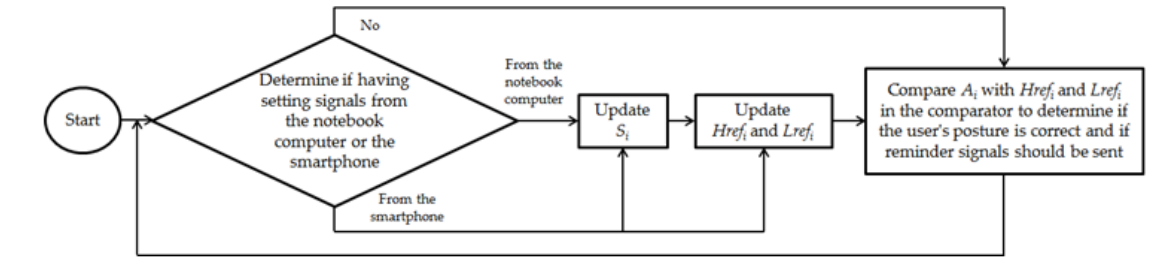
Figure 7. Hysteresis